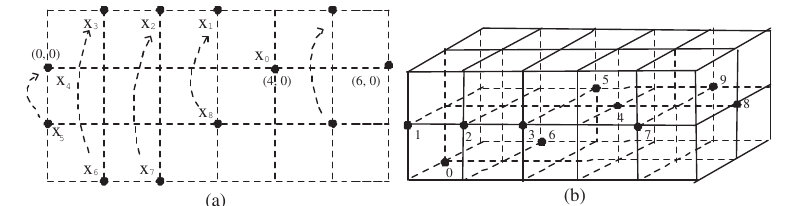
∨ C 2,4 )) = [ 0,12 ] Z . ( b ) For F ( Con 8 8